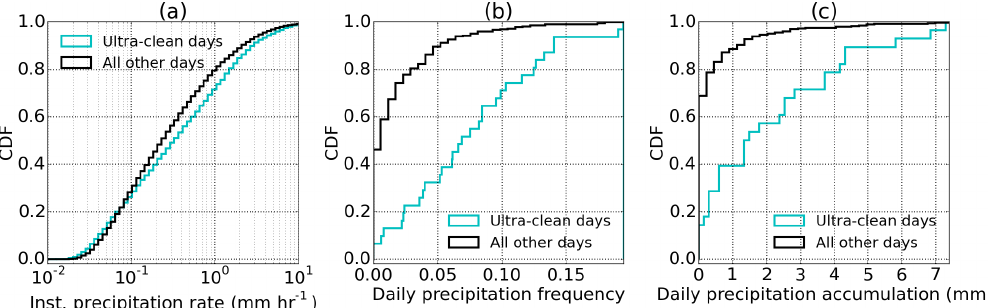
Figure 4. Cumulative distributions of (a) instantaneous precipitation rate, (b) daily precipitation frequency and (c) daily precipitation accu- mulation as measured by the ASI Parsivel 2 laser disdrometer.